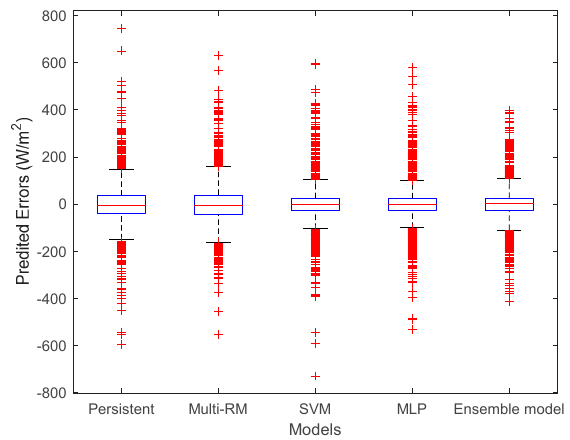
Figure 8. Predicted error distributions of the 5 models in Table 5.